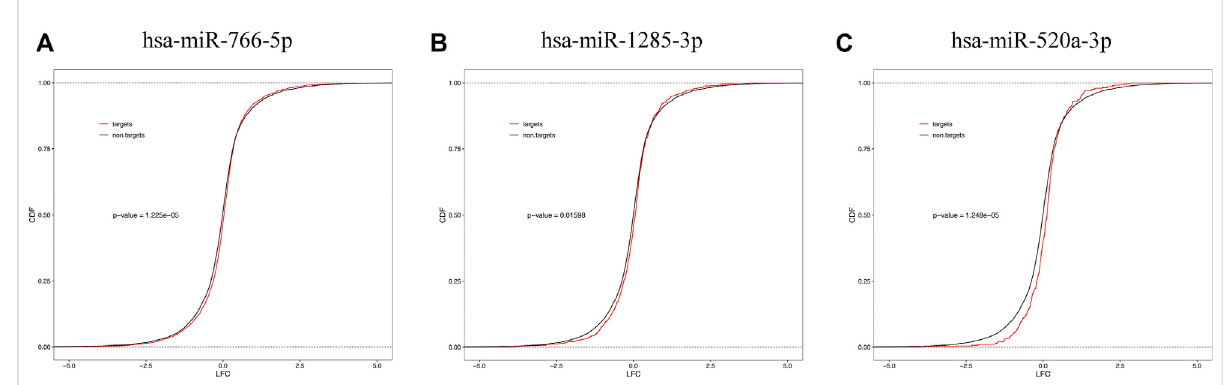
FIGURE 7 CumulativefrequencyofmRNAslog2foldchangebasedonmiRNAtargetstatus.mRNAtargetsofdownregulatedplasmamiRNAs[miR-766-5p